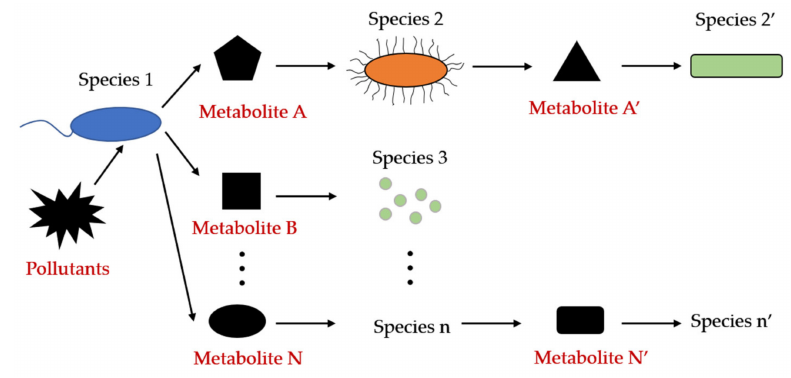
Figure 2. Division of labor in a metabolic pathway.